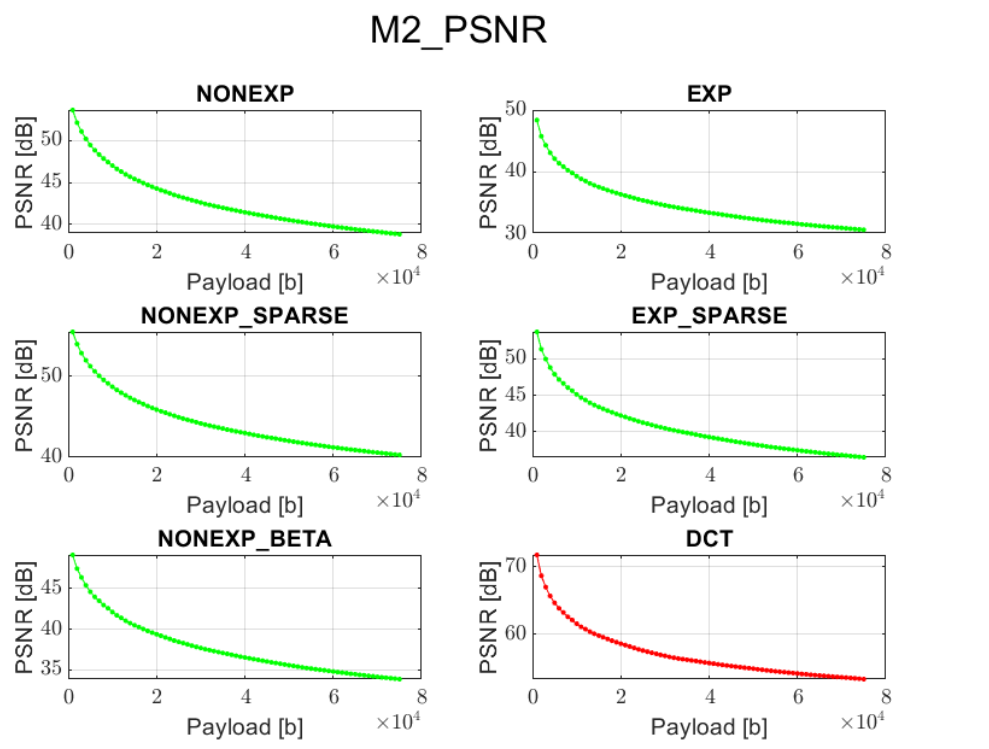
Figure 3. Relation between PSNR and embedded data size for method 2 and all transform